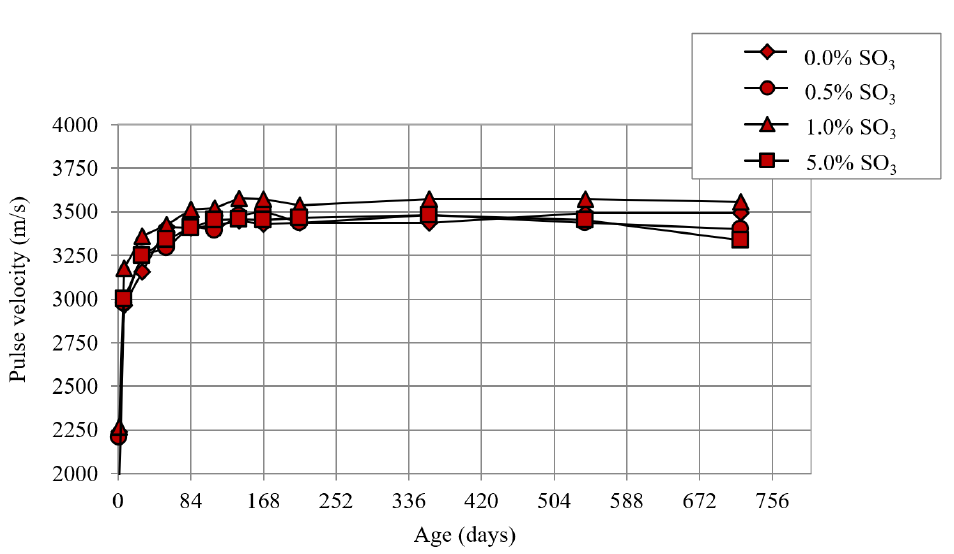
Figure 3. Pulse velocity monitoring for the series (0.0%, 0.5%, 1.0% and 5.0% SO 3